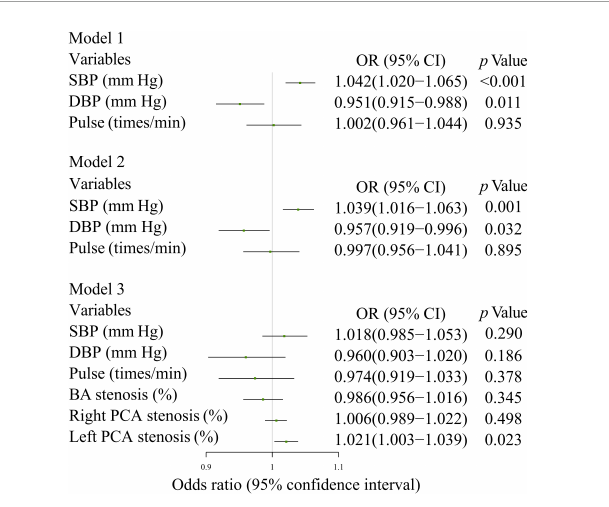
FIGURE4 Multivariate logistic regression analysis of the relationship between the means of various BP parameters and CI. Model 1: SBP, DBP, and Pulse; Model 2: model 1 + BMI, previous myocardial infarction history, and previous stroke history; Model 3: model 1 + BA stenosis score, right and left PCA stenosis scores. SBP, systolic blood pressure; DBP, diastolic blood pressure; PP, pulse pressure; MAP, mean arterial pressure; PPI, pulse pressure index; BMI, body mass index; BA, basilar artery; PCA, posterior cerebral artery.